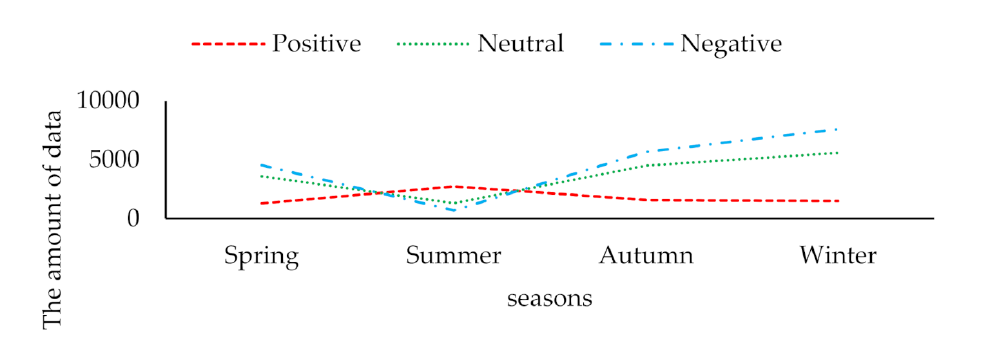
Figure 3. The amount of data marked by artificial emotion